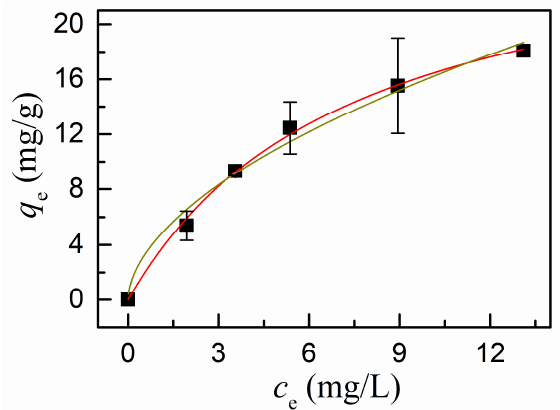
Figure 6. Dependence of the adsorbed Cd(II) per gram adsorbent ( q e ) on the equilibrium concentration ( c e ). The solid lines correspond to the fitting of the data to Langmuir ( red line ) and Freundlich ( dark green line ) isotherm model.